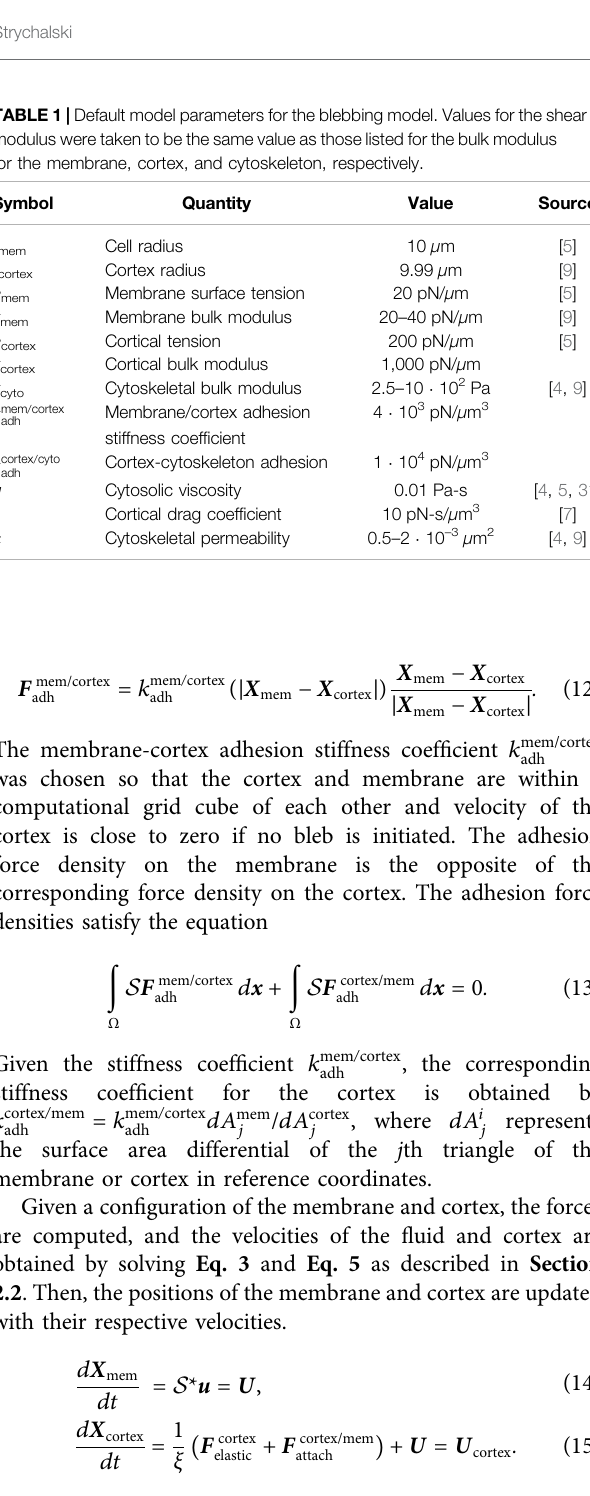
Table 1 lists the default parameters for blebbing simulations.